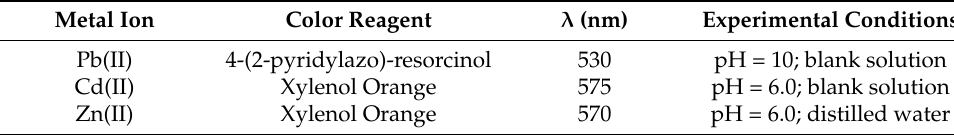
Table 1. Spectrophotometric methods used for the analysis of heavy-metal ions